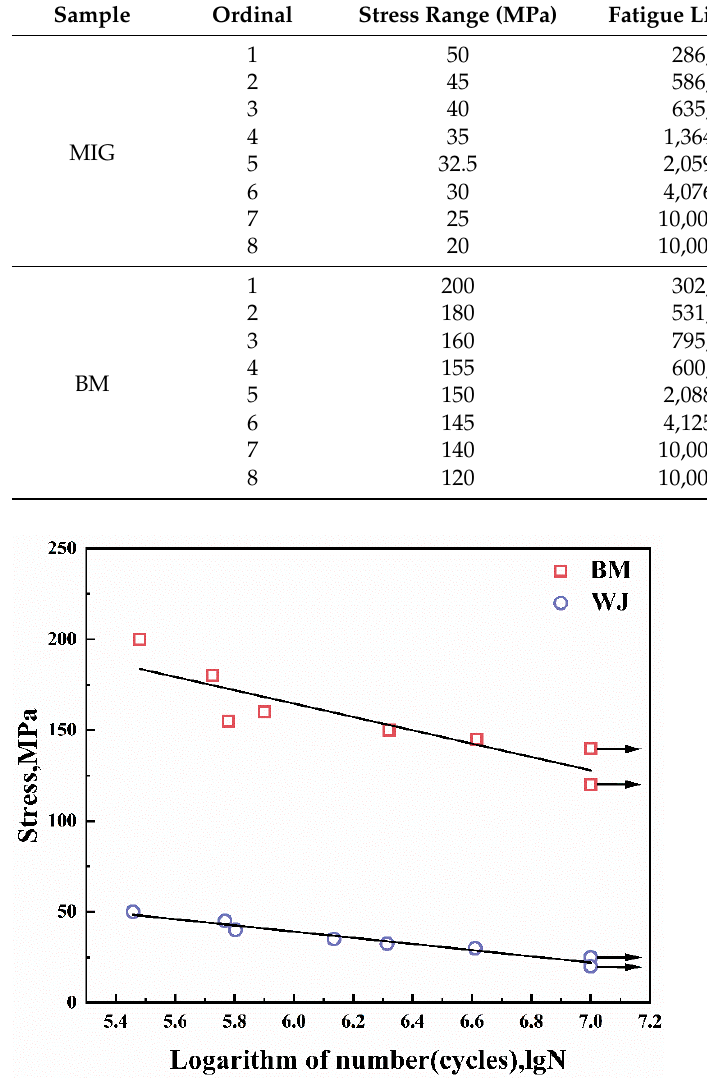
Figure 5. Relationship between stress and fatigue life of welded joint and base